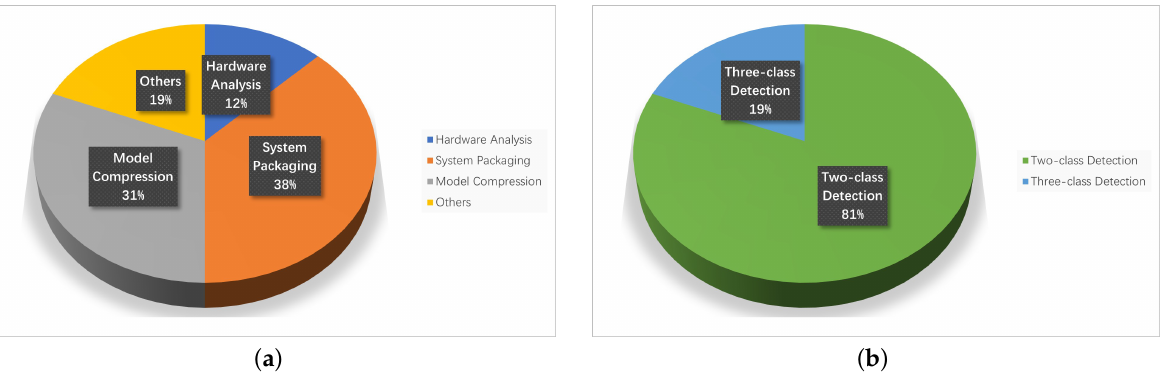
Figure 3. Sector graphs for mask-face detection hardware system classifications. ( a ) Contributions of different approaches; ( b ) Proportions for two-class and three-class mask-face detection